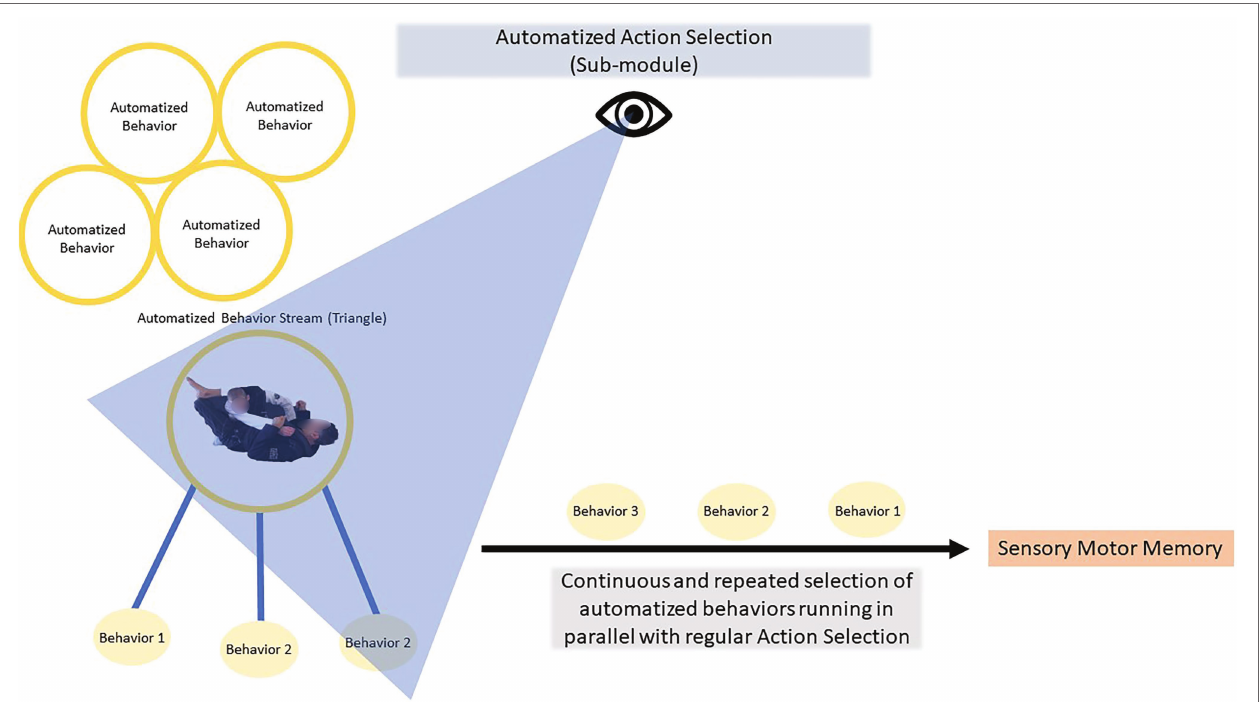
FIGURE 7 | The Automatized Action Selection sub-module rapidly chooses one behavior at the time from candidate automatized behaviors (much like regular Action Selection). Like pearls on a string these behaviors are sent forward to Sensory Motor Memory at high speed; all in parallel with whatever might be happening in Action Selection. Differently from regular Action Selection selected automatized behaviors also “calls” for the next action to be selected to insure rapid smooth unfolding of the overlearned series of